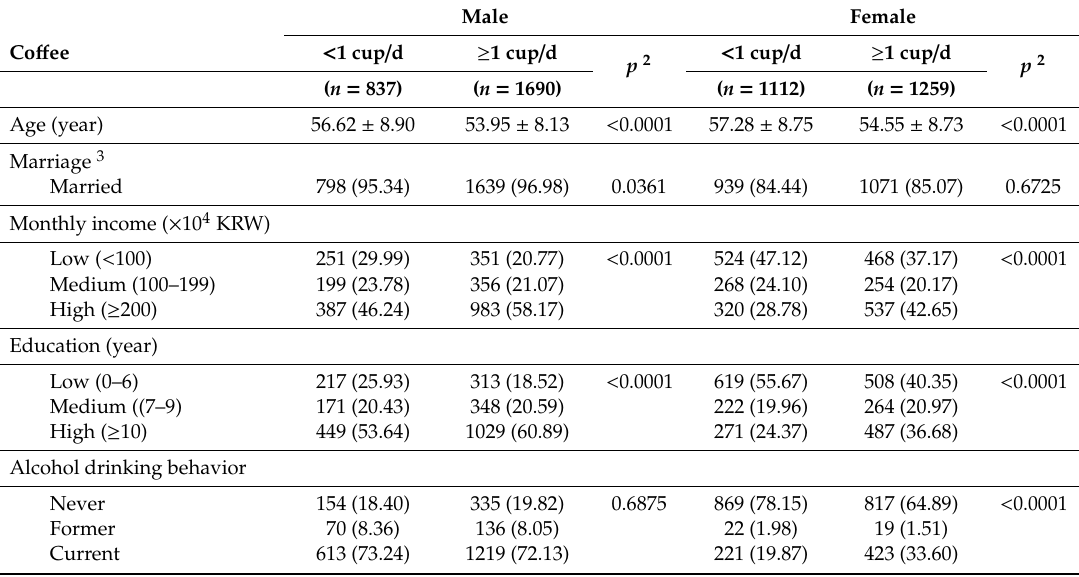
Table 2. Basic Characteristics depending on the amount of co ff ee intake in male and female 1 . Male